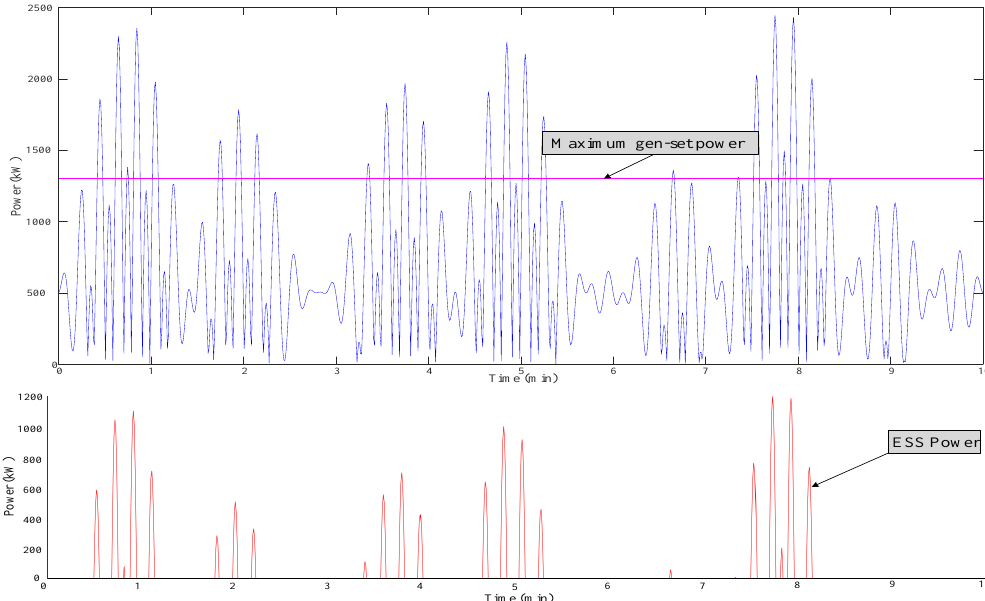
Figure 14. Peak shaving application in marine